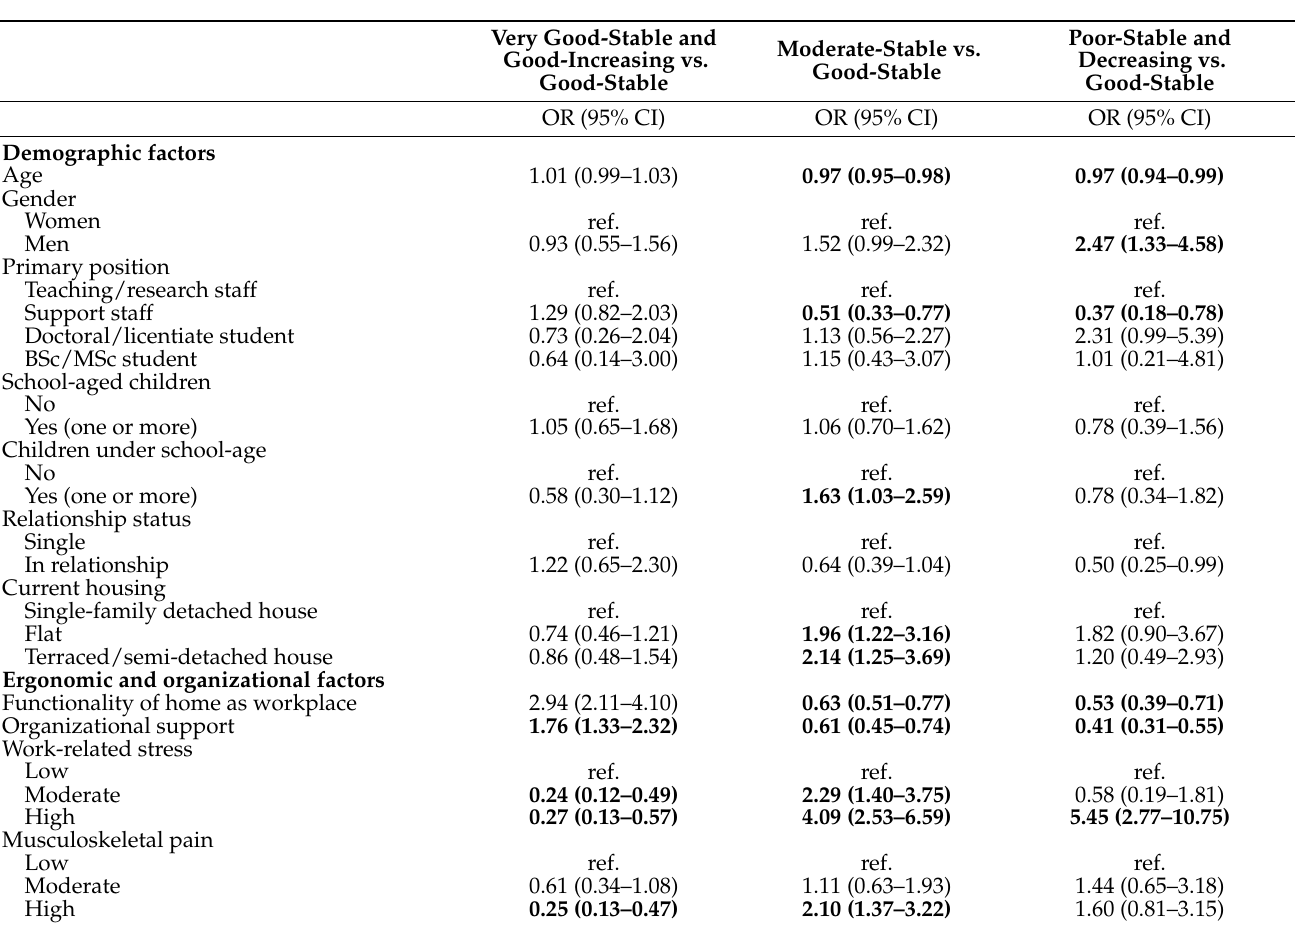
Table 2. Univariate associations between profiles of work ability among university staff during COVID-19 lockdown with baseline predictors. Multinomial logistic regression analysis odds ratios (OR) and 95% confidence intervals (CI). Very Good-Stable and Poor-Stable and Moderate-Stable vs. Good-Increasing vs. Decreasing Good-Stable